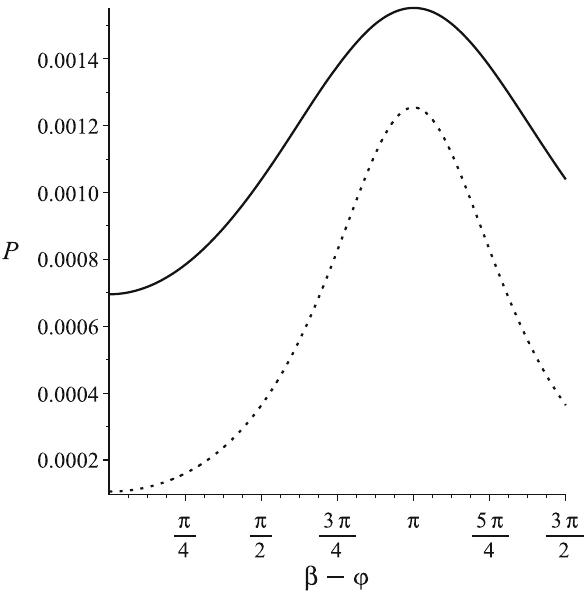
Fig. 6 P as a function of β − ϕ for for p / p (cid:8) = 0 . 3 solid line and p / p (cid:8) = 0 . 1 the point line. Parameter k = 1 .